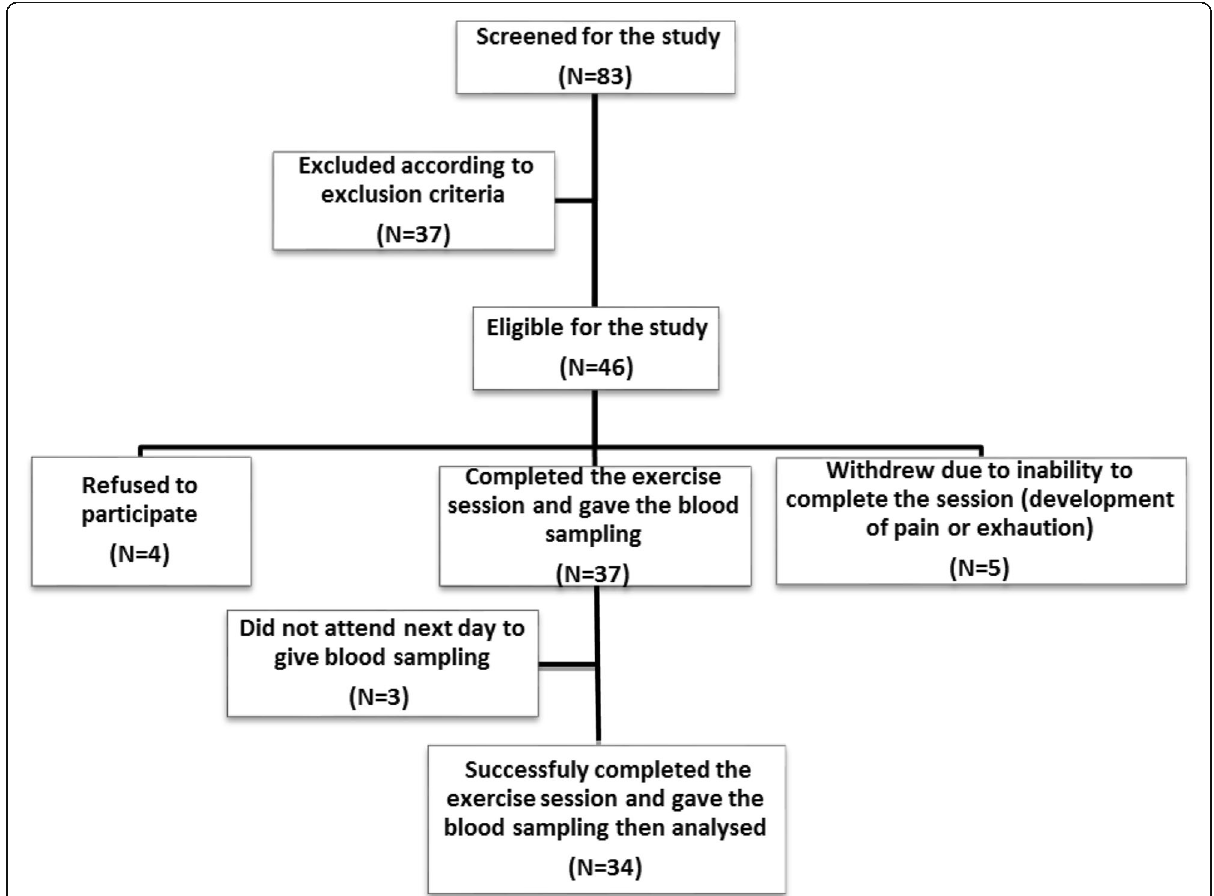
Fig. 1 Participant flowchart from screening to data